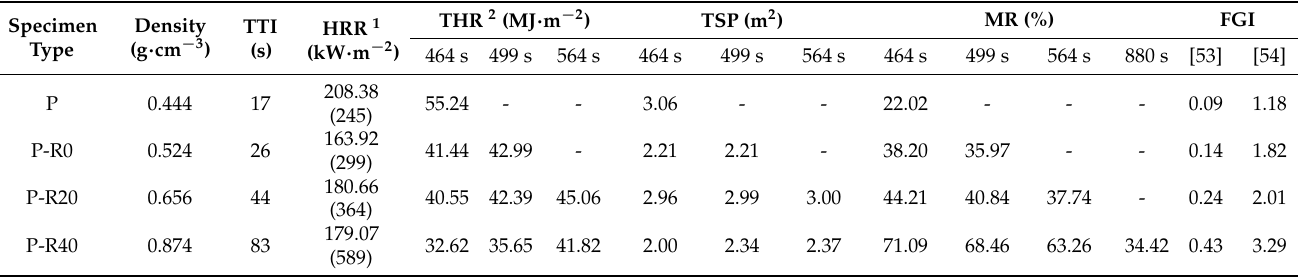
Figure 6. Burning phenomena in cone calorimeter tests. Initial ignition of all specimens during initial period ( a ), stable burning at relatively low speed ( b ), post-ignition violent combustion ( c ), and gradual burn to end ( d ). Table 2. Fire resistance of control and modified poplar wood